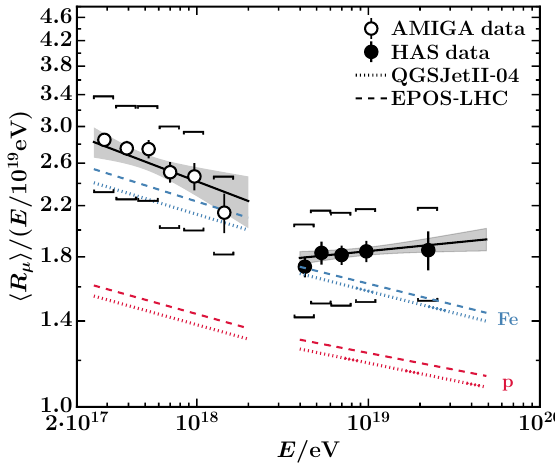
Figure 4. Average muon content (cid:104) R µ (cid:105) per shower energy E as a function of the shower energy E for AMIGA and inclined shower recorded by SD (HAS). Square brackets indicate the systematic uncertainty of the measurement. The grey band indicates the sta- tistical uncertainty of the fitted lines to each data set. Shown for comparison are theoretical curves for proton and iron showers simulated at θ = 35 ◦ for AMIGA and 67 ◦ for